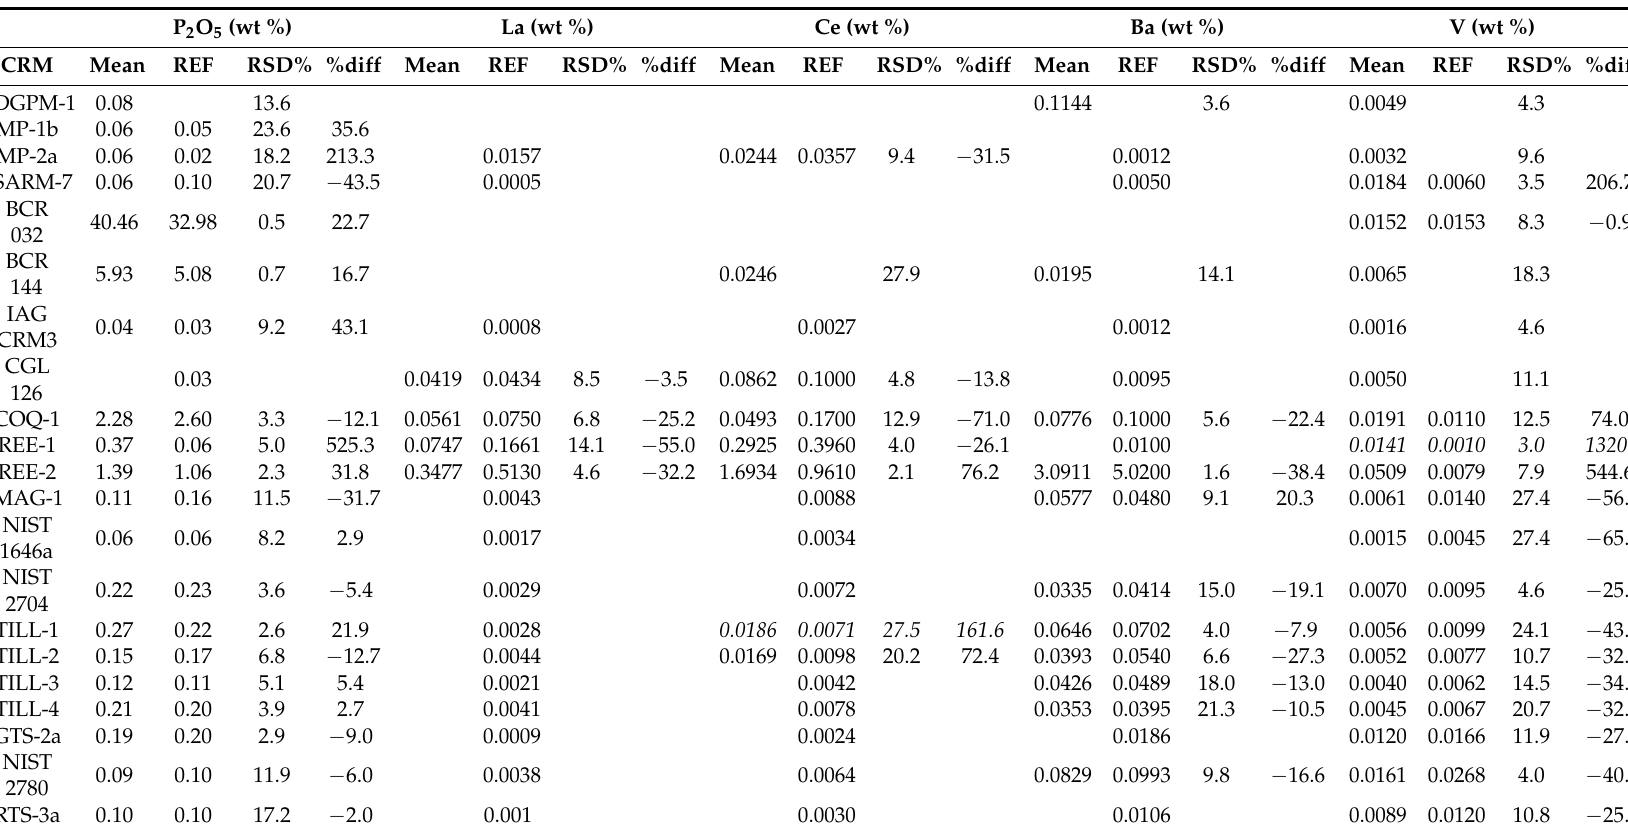
Table 3. Summary of results and statistical parameters of selected critical elements. La and Ce were determined in GeochemGeneral mode, all other elements were determined using GeochemTrace mode. REF is the reference value stated in the CRM certificates. Highly erroneous results (false positives) are shown in